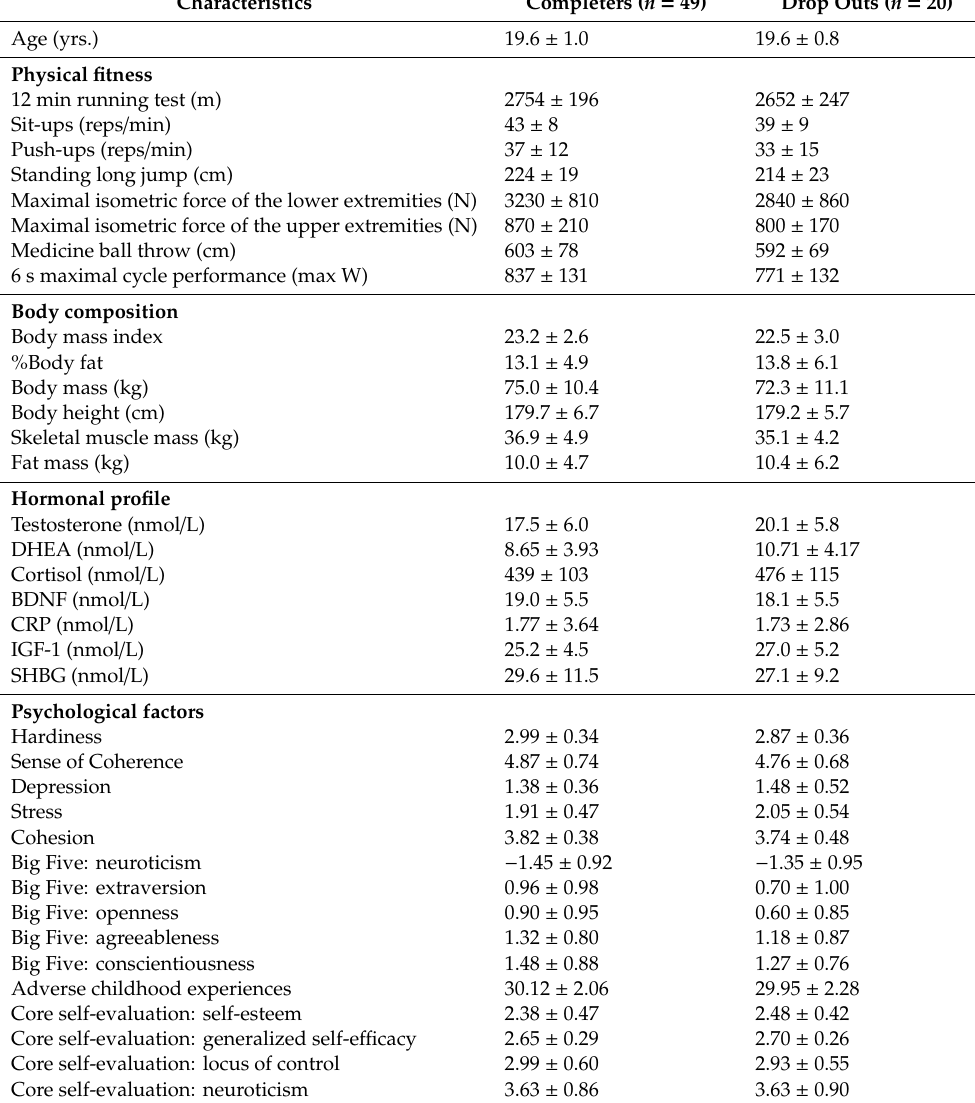
Table 1. Demographic, physical fitness, body composition, hormonal and psychological factors in those completing survival training and those who drop-out (mean +